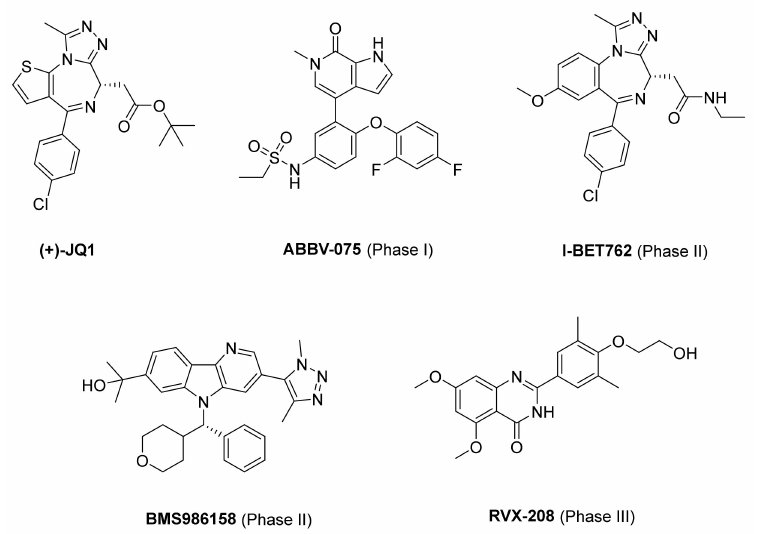
Figure 1. Chemical structures of representative BET bromodomain